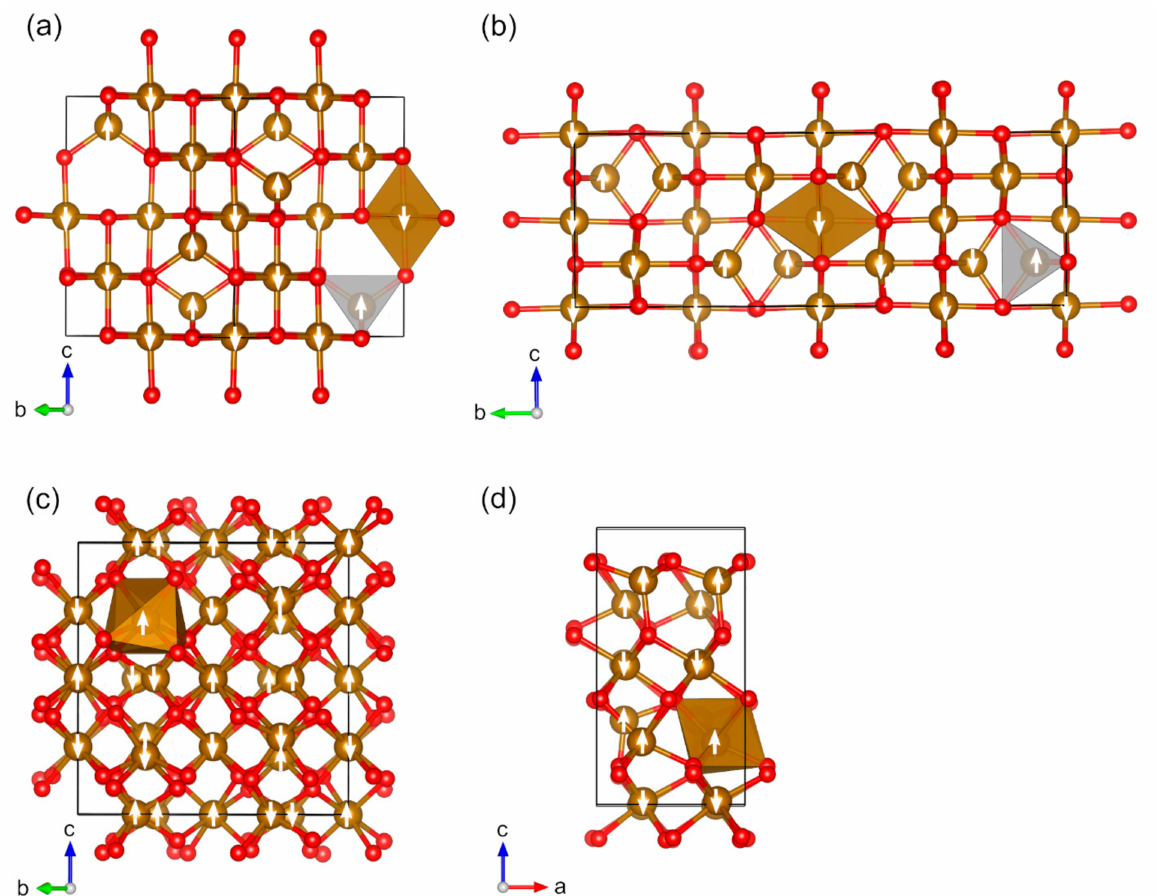
Figure 6. Optimized structures of studied magnetic binary iron oxides (red: O, brown: Fe): ( a ) Fe 3 O 4 ( cF56 ), ( b ) Fe 3 O 4 ( mP56 ), ( c ) Fe 2 O 3 ( cI80 ), and ( d ) Fe 2 O 3 ( oP40 ). The directions of magnetic moments are illustrated by white arrows. Coordination octahedra and tetrahedra of Fe atoms are shown in brown and light-grey colors,